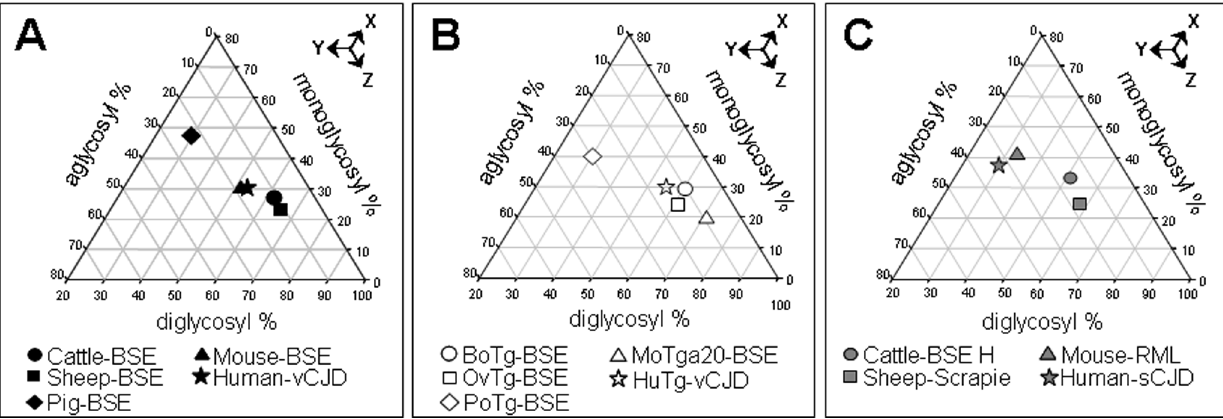
Figure 2. Glycoform ratios of PrP res detected by Western blotting. PrP res was detected with the Sha31 monoclonal antibody in the different BSE-derived prions propagated either in the natural hosts (A) or in transgenic mouse models over-expressing their corresponding PrP C sequence (B). Atypical cattle-BSE H, sheep-scrapie, mouse-RML and human-sCJD isolates (C) are included for comparison purposes. Values are the normalized means from at least six repeated runs. Arrows indicate the reading direction of the